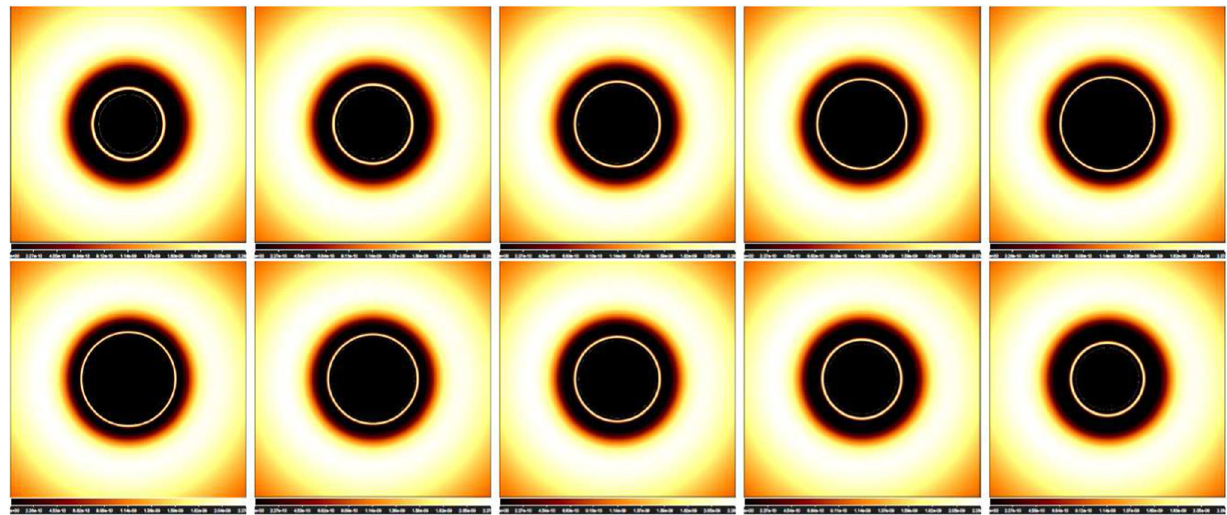
Fig. 1 Image of a geometrically thin infinite accretion disk around a Schwarzschild black hole by polarized light coupled with Weyl tensor for the observer with r o = 100 M and θ o = 0 ◦ . The upper row is for